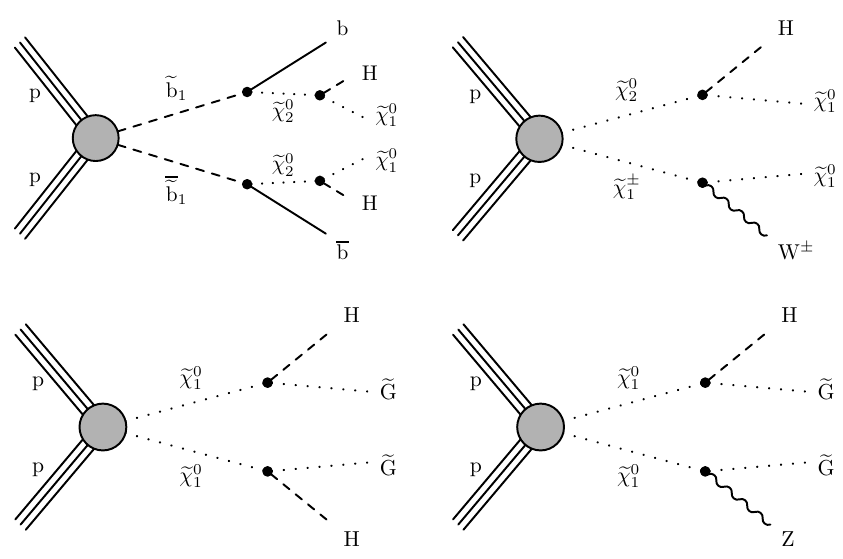
Figure 1 . Diagrams displaying the simpli(cid:12)ed models that are being considered. Upper left: bottom squark pair production; upper right: wino-like chargino-neutralino production; lower: the two relevant decay modes for higgsino-like neutralino pair production in the GMSB